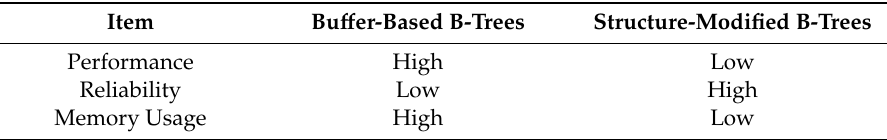
Table 1. Bu ff er-based B-Trees vs. Structure-modified